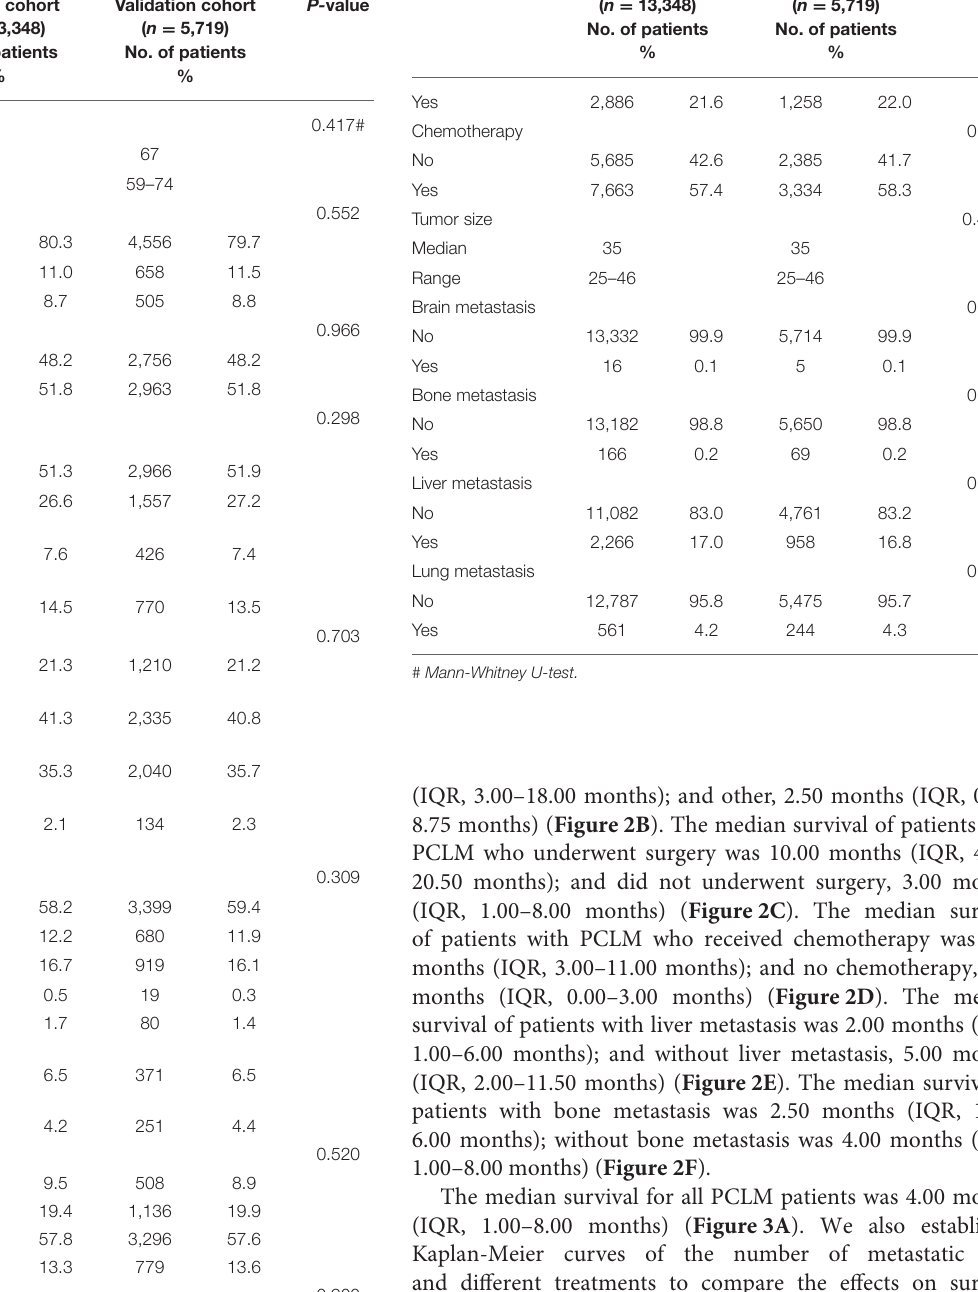
TABLE 1 | Demographic and clinicopathological characteristics in pancreatic cancer patients.